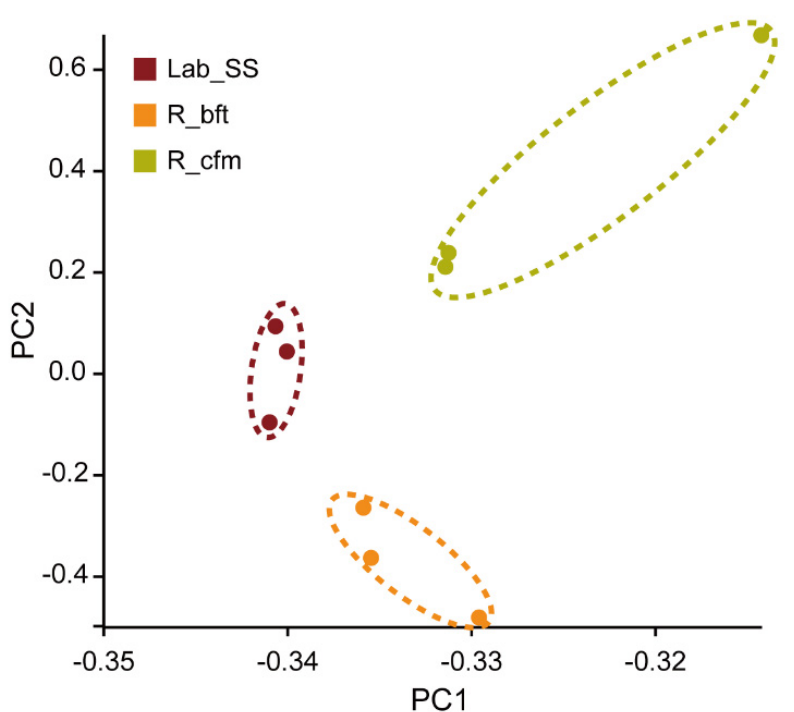
Figure 3. PCA plots of the susceptible strain (Lab_SS), cyflumetofen- (R_cfm) and bifenthrin-resistant (R_bft) strains of T. urticae . Different colours represent different treatments ( : Lab_SS; : R_cfm).